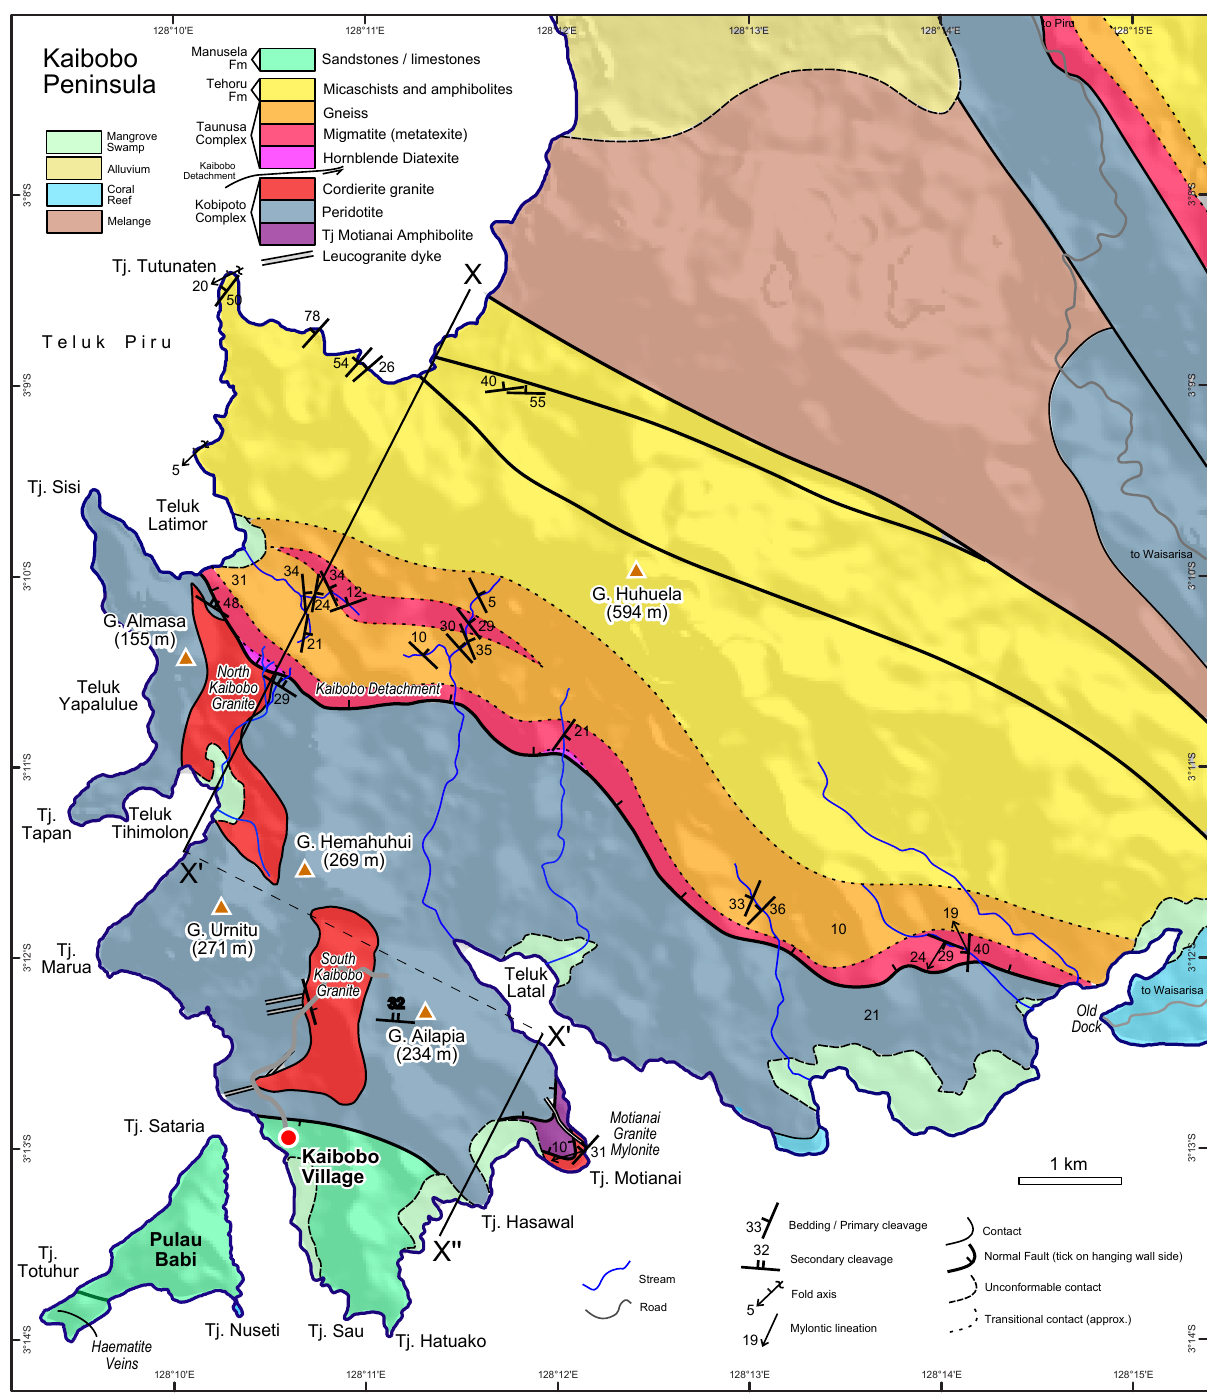
Fig. 5. Geological map of the Kaibobo Peninsula, western Seram, constructed from stream sections and coastal outcrop accessed by boat, and traverses made from Kaibobo Village. See Fig. 6 for a cross section along profile X–X 0 –X 00 , and see Fig. 3 for map location.